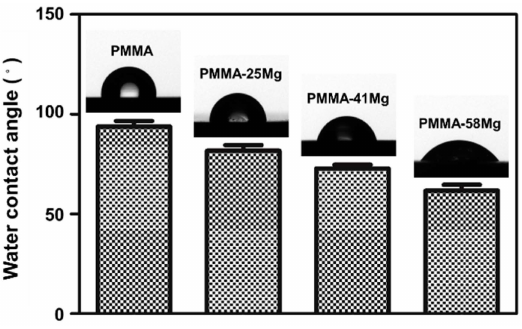
Figure 3. Water contact angle of PMMA, PMMA–25Mg, PMMA–41Mg, and PMMA–58Mg.